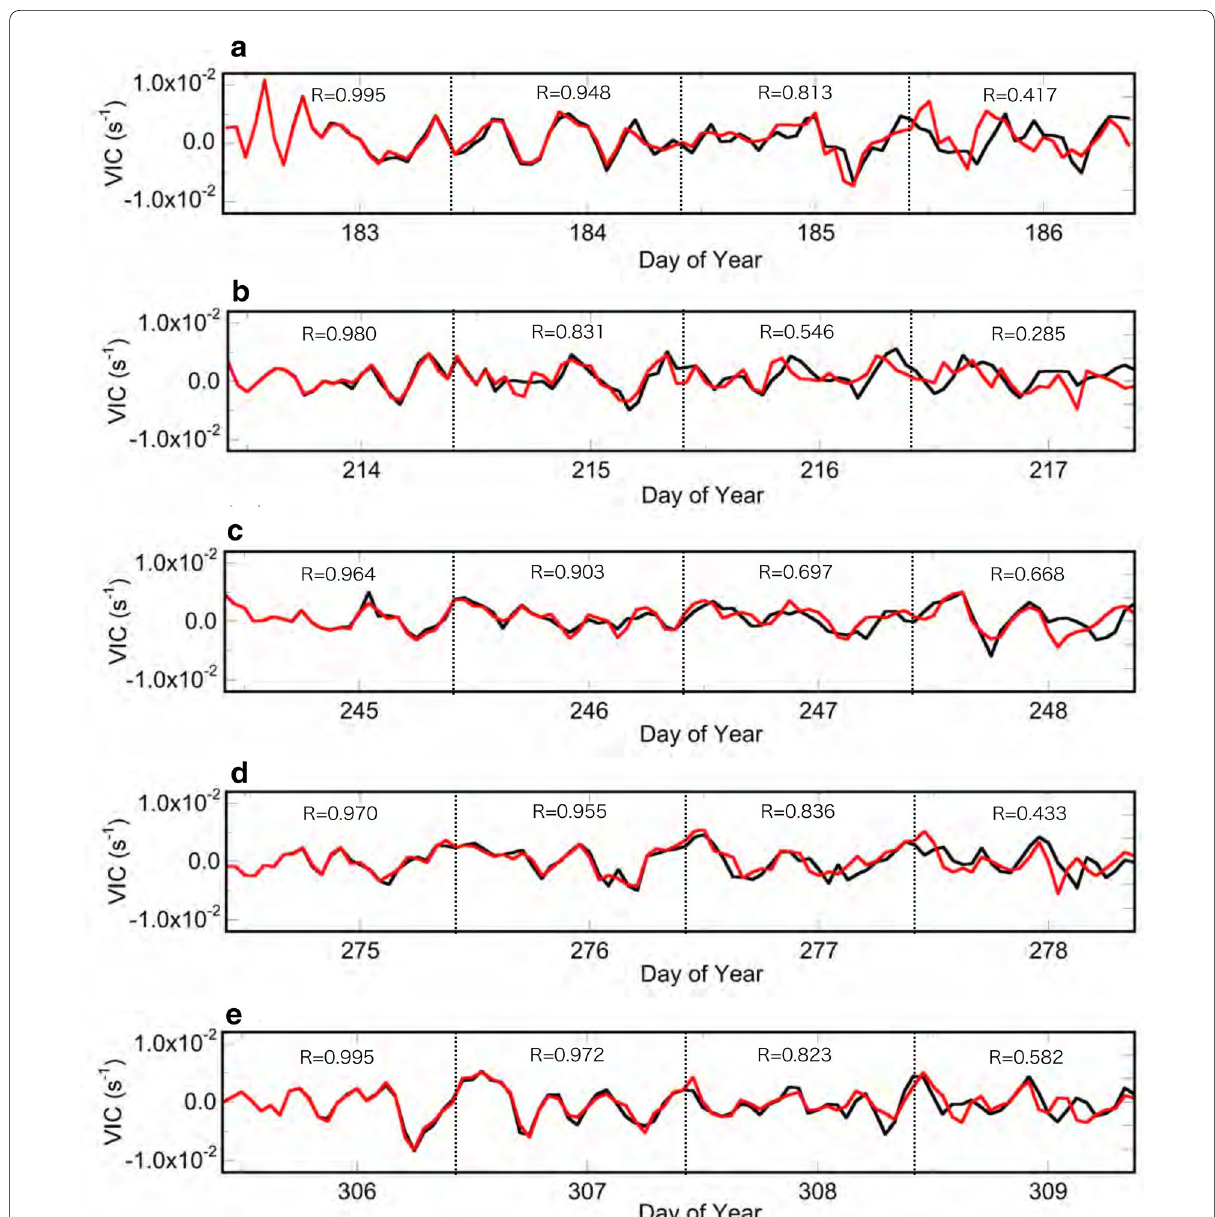
Fig. 11 Comparisons of VIC 120 with and without JRA-55. The vertical ion convergence values at 120 km ( VIC 120 ) with and without JRA-55 are compared for the same periods as Fig. 10, starting from the same initial values. The black line and the red line indicate VIC with and without JRA-55, respectively. Numbers for each day are correlation coefficients of VIC 120 with and without